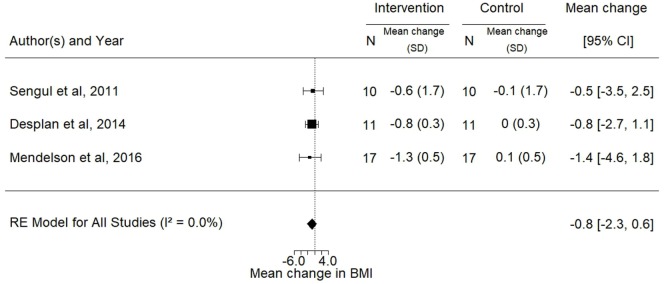
Forest plot for the mean change in body mass index (BMI) (kilogram per square meter) following exercise training. The diamond reflects the 95% confidence interval of the pooled estimate of mean difference. Ref (22, 30, 33).